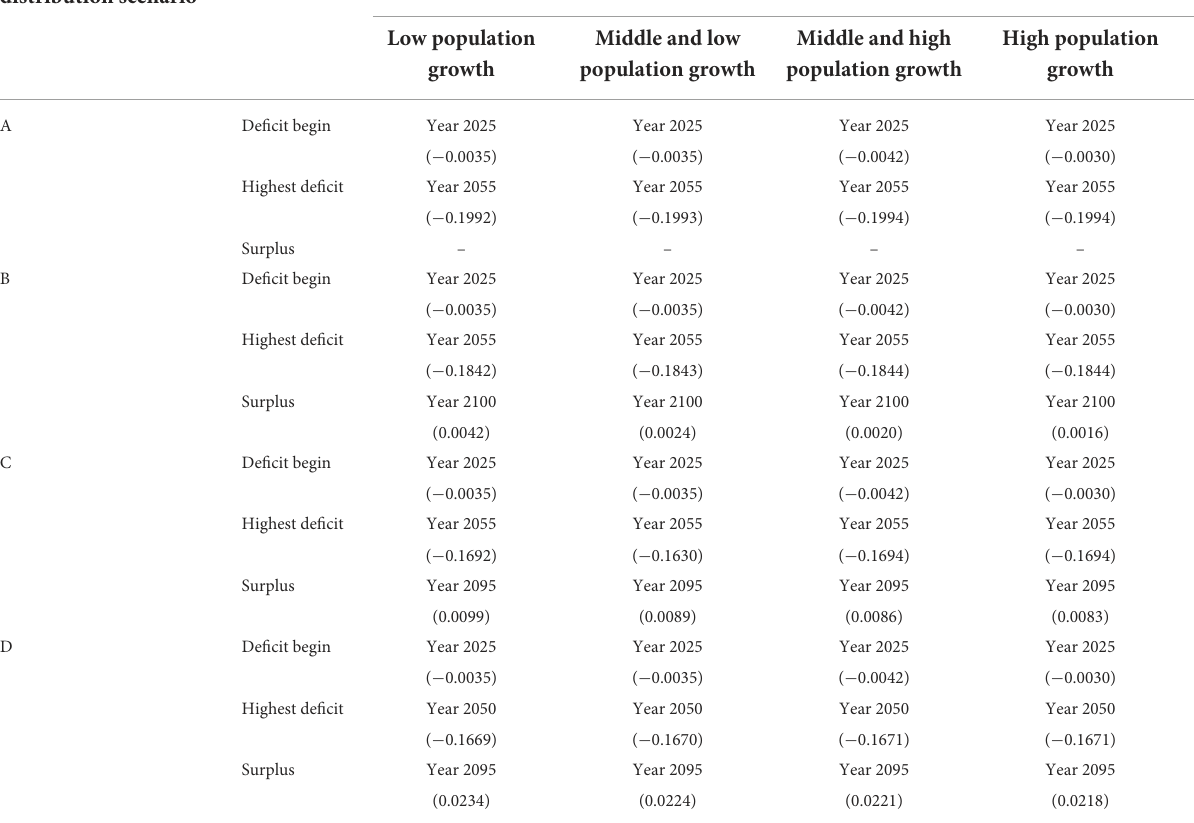
TABLE 2 Financial deficit or surplus of the LTCI system as a percentage of GDP under the low economic growth scenario (%). Disposable